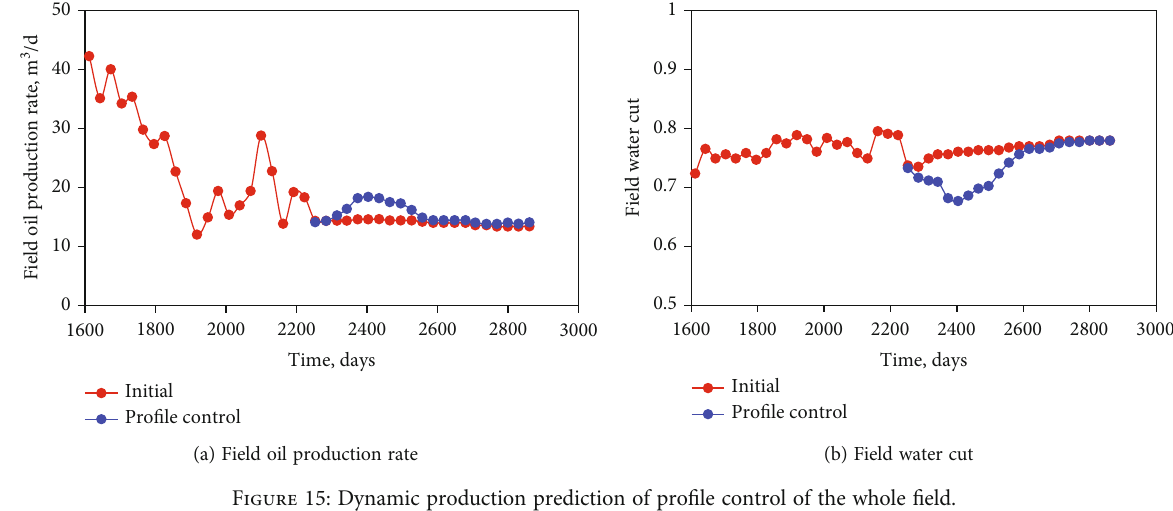
Figure 15: Dynamic production prediction of pro fi le control of the whole fi eld.